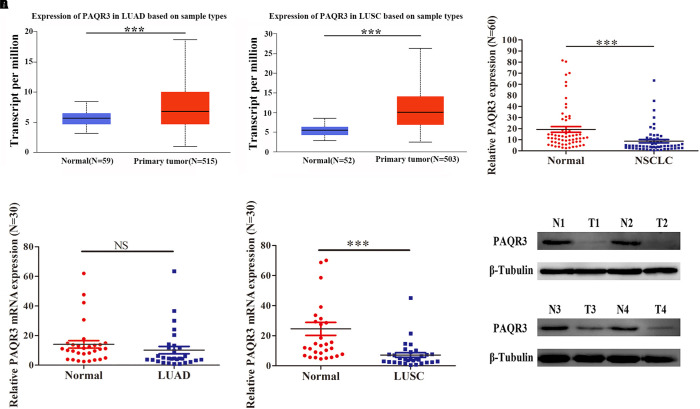
Expression of PAQR3 in Ualcan database and 60 clinical NSCLC samples. (A,B) PAQR3 mRNA level in LUAD and LUSC from Ualcan Database. (C–F) Expression of PAQR3 in 60 collected NSCLC samples. Note: Normal, normal lung tissue; NSCLC, non-small cell lung cancer; LUAD, lung adenocarcinoma; LUSC, lung squamous carcinoma; ***P < 0.001; NS, no statistical significance; vs. Normal.